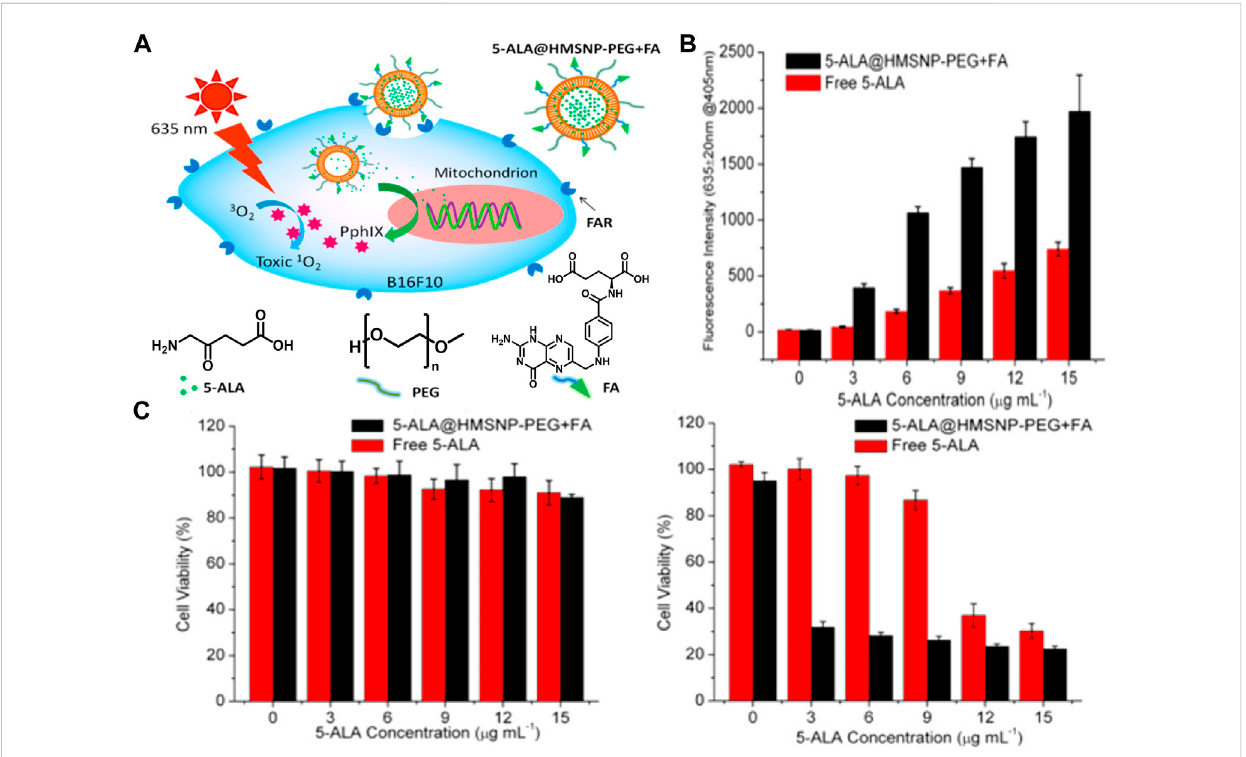
FIGURE 14 (A) Design and mechanism of ALA@HMSNP-PEG + FA; (B) PpIX generation in B16F10 cancer cells after treatment with ALA@HMSNP-PEG + FA and free ALA; (C) Cell viabilities after treated with ALA@HMSNP-PEG + FA and free ALA without and with light irradiation. Adapted from ref. (Ma et al., 2015). Copyright 2015 American Chemical